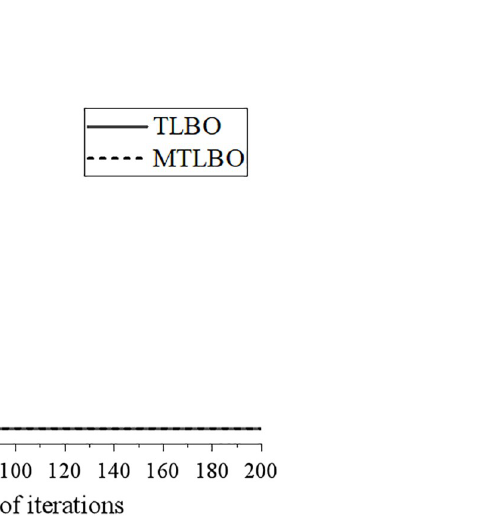
Fig 6. Convergence curves of the two algorithms in the Rastrigin function.